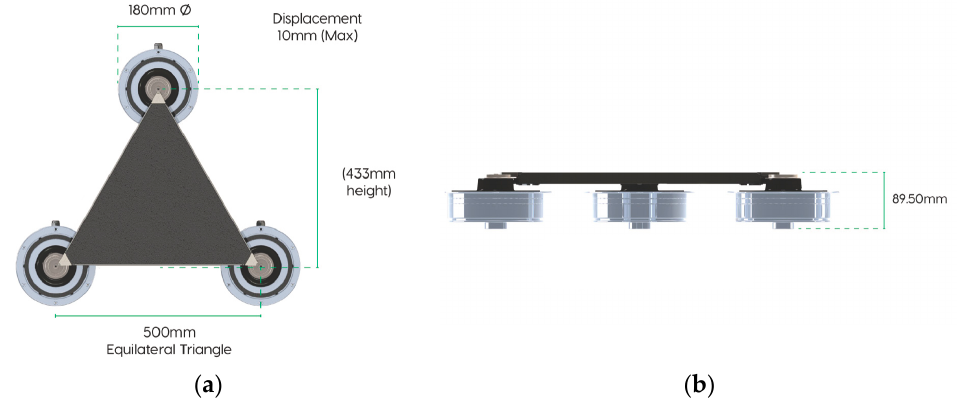
Figure 30. V3 ® version of Pavegen’s tile [68]; top view ( a ), side view ( b ).